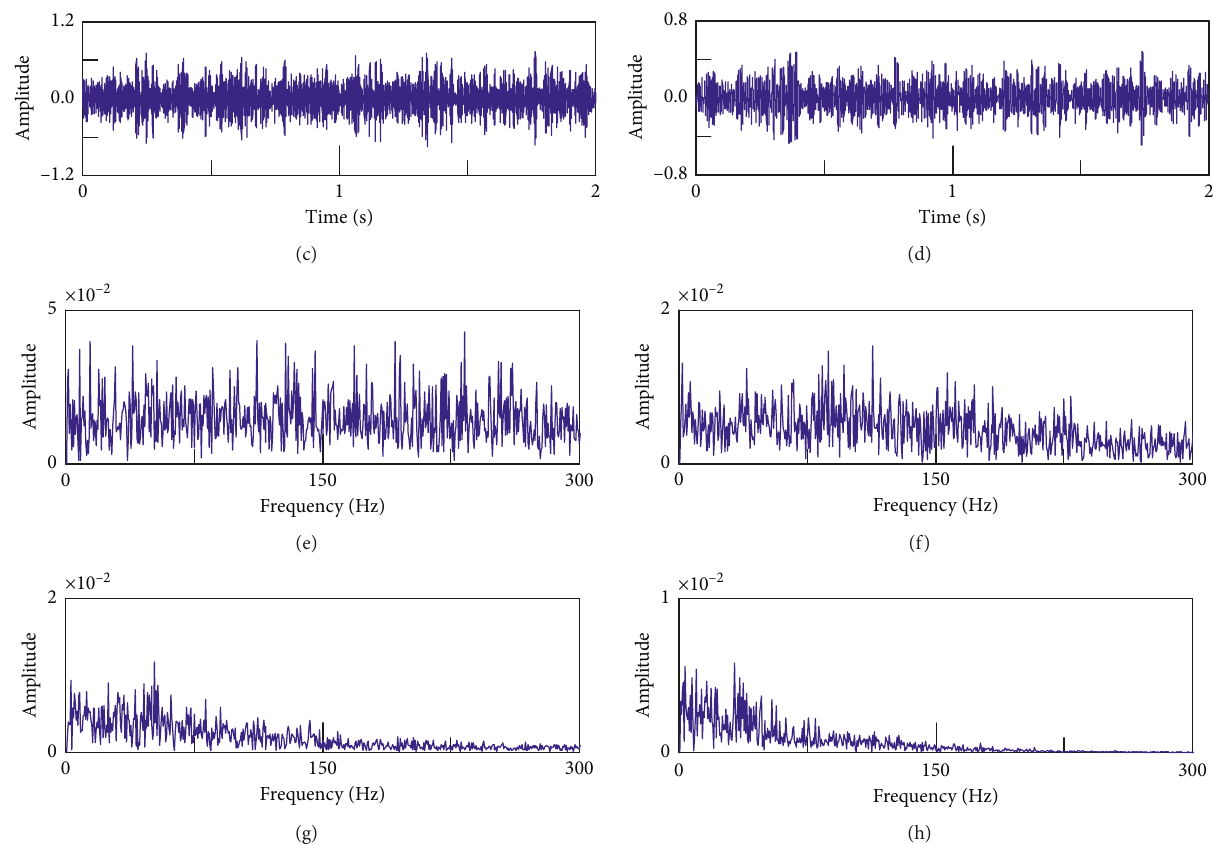
Figure 13: Results obtained by EEMD: (a–d) IMFs; (e–h) squared envelope spectra.